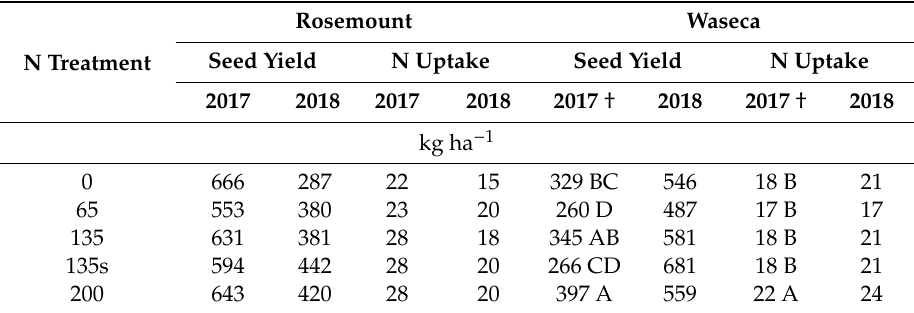
Table 6. Pennycress seed yield and N Uptake as impacted by sweet corn N treatment for Rosemount and Waseca during the 2017 and 2018 growing